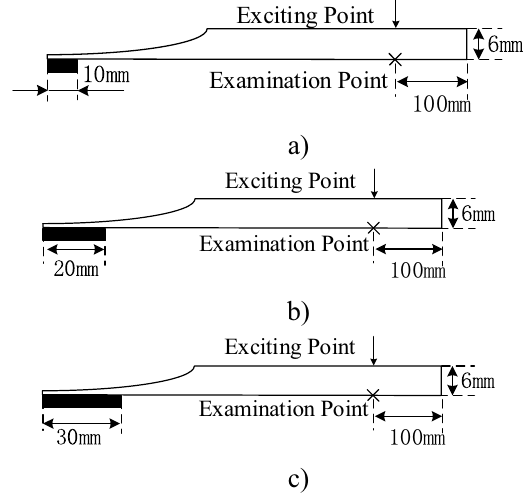
Figure 5: Calculation conditions with di ff erent damping layer length ratios: ( a ) Condition 1 φ = 10%. ( b ) Condition 2 φ = 20%. ( c ) Condition 3 φ =